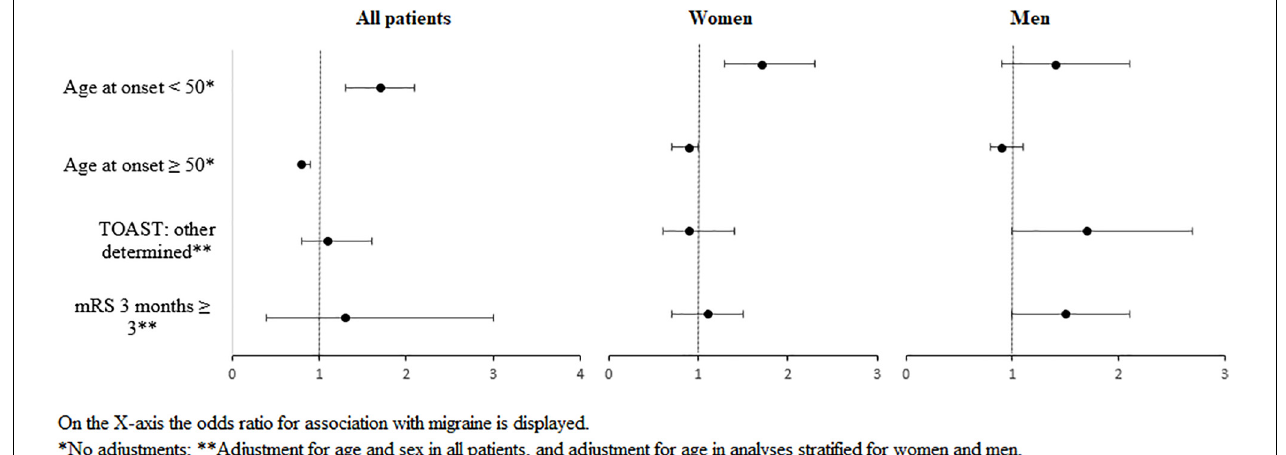
FIGURE 1 | Forest plot of the most important findings on associations between migraine and risk factors, etiology, or outcome of stroke, stratified for